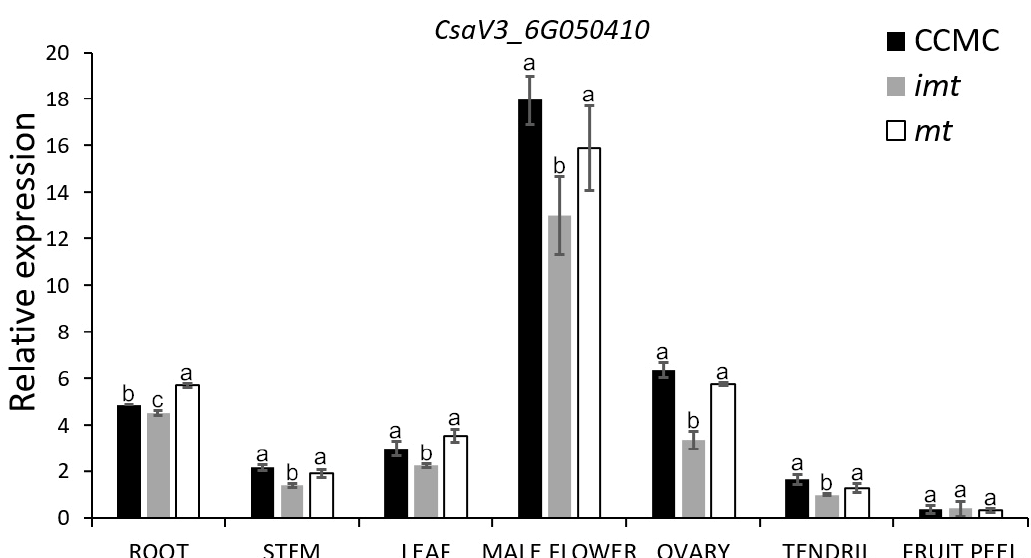
Figure 5. Relative expression level of CsaV3_6G050410 . Relative expression of the CsaV3_6G050410 gene in the root, stem, leaf, male flower, ovary, tendril and fruit peel of the WT, the mt and their F 1 progeny ( imt ) by qRT-PCR. Data are displayed using the Actin gene as an internal control with three biological and three technical replicates. Values are the mean ± SD. Letters above the bars indicate significant differences at p < 0.05.